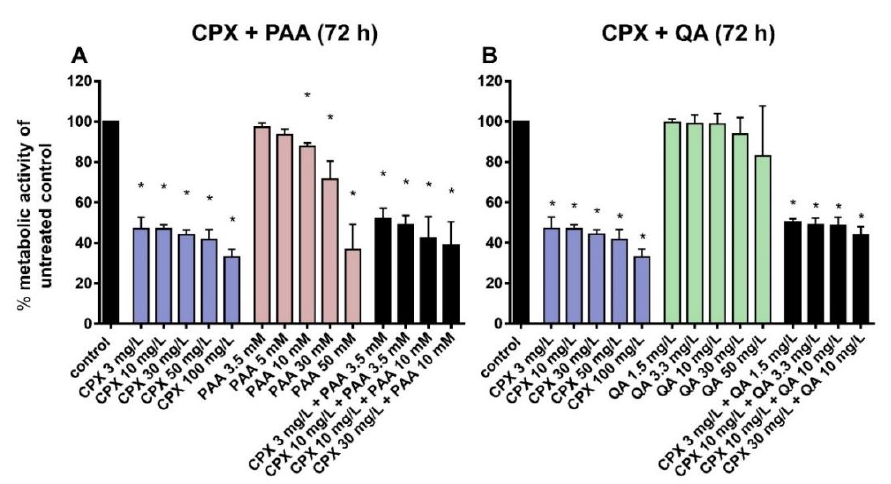
Figure 2. Metabolic activity after 72 h preincubation with CPX ( A , B ), PAA ( A ), QA ( B ) alone, and combinations of CPX and PAA ( A ) and CPX and QA ( B ). The effects of phenylacetic acid (PAA) and quinolinic acid (QA) alone or in combination with ciprofloxacin (CPX) on tenocyte metabolic activity were detected by measuring reduction of alamarBlue after 72 h of incubation. Results are expressed as a percentage of the activity observed in untreated controls. Bars show the mean ± standard deviation (SD) obtained from four independent experiments with tenocytes from different patients. * p ≤ 0.05 compared to control.